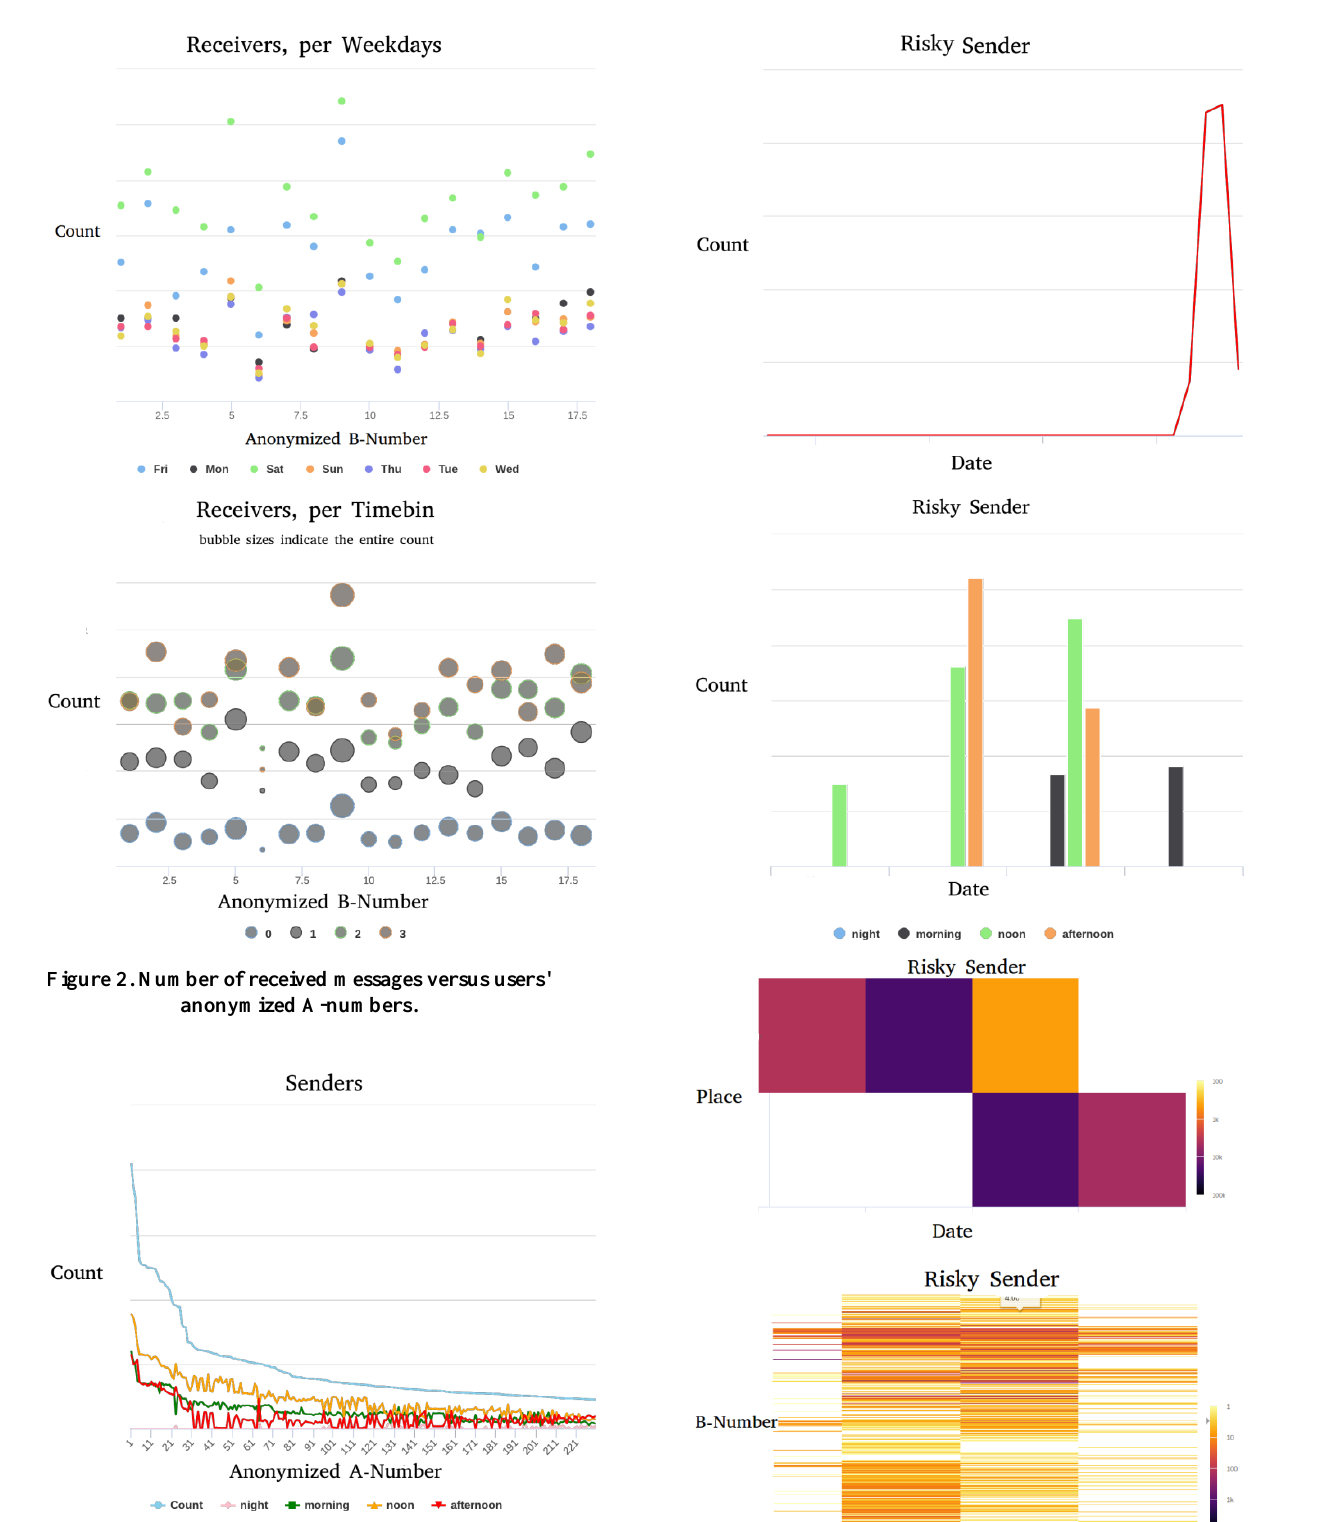
Figure 3. Number of sent messages versus sender anonymized A-numbers within time-bins of the day.